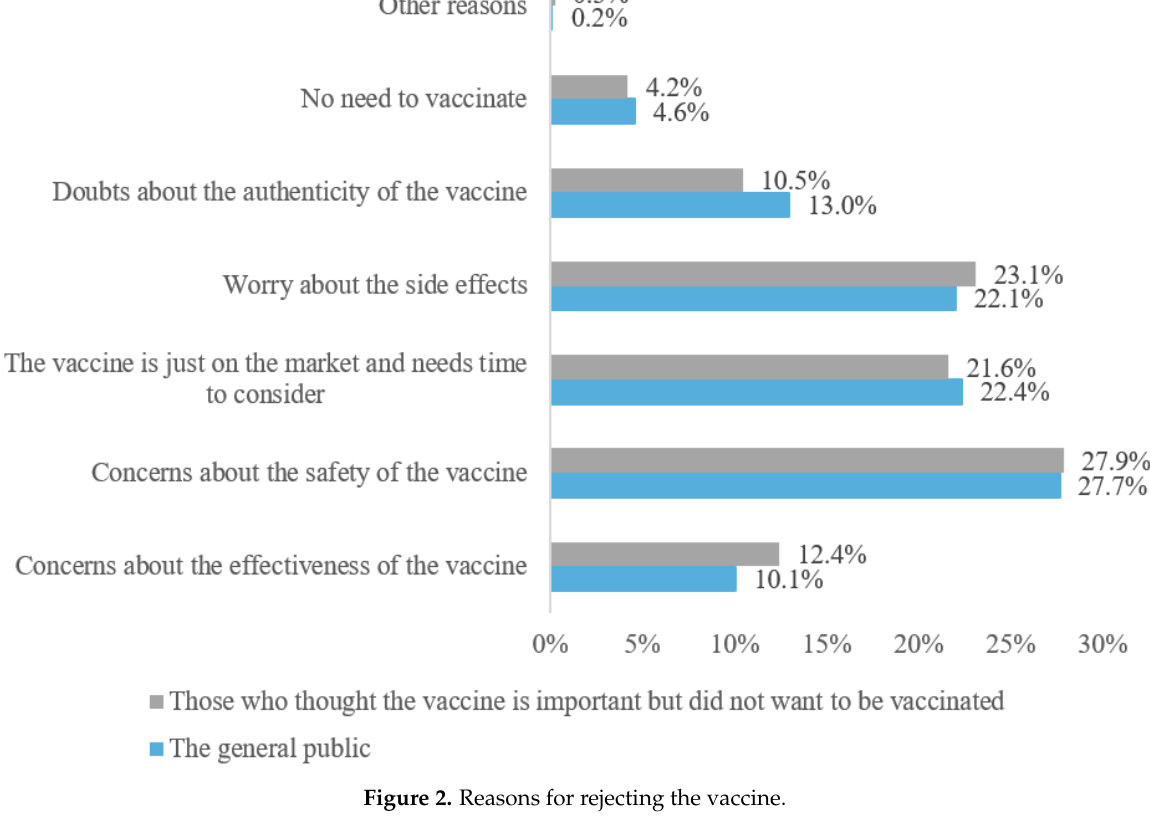
Figure 2. Reasons for rejecting the vaccine.